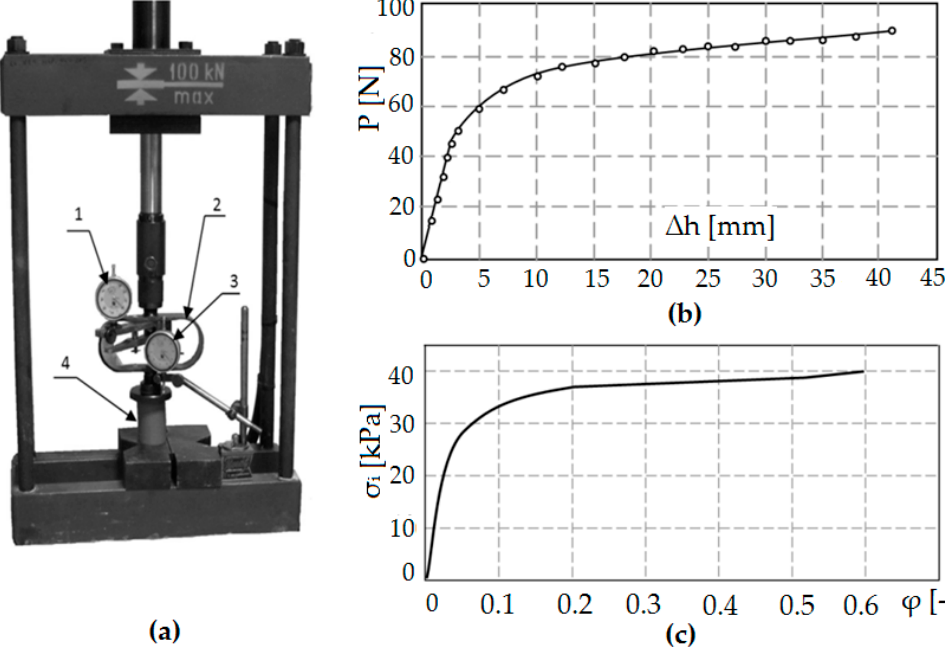
Figure 12. Stand for static compression test on the model material: 1—bow dynamometer, 2—dial displacement sensor, 3—compressed sample, and 4—dial gauge calibrated in force units ( a ), change of the compressive force P as a function of the height change ∆ h of the cylindrical sample ( b ), the actual compression diagram for the model material ( c ).